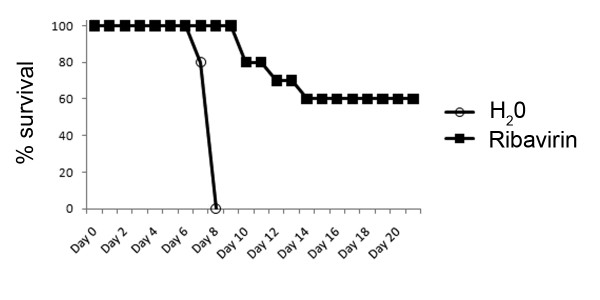
Efficacy of ribavirin against MACV infection. STAT-1 knockout mice were infected with MACV and treated daily with ribavirin or vehicle (water) beginning 1 hour after infection (n = 10).